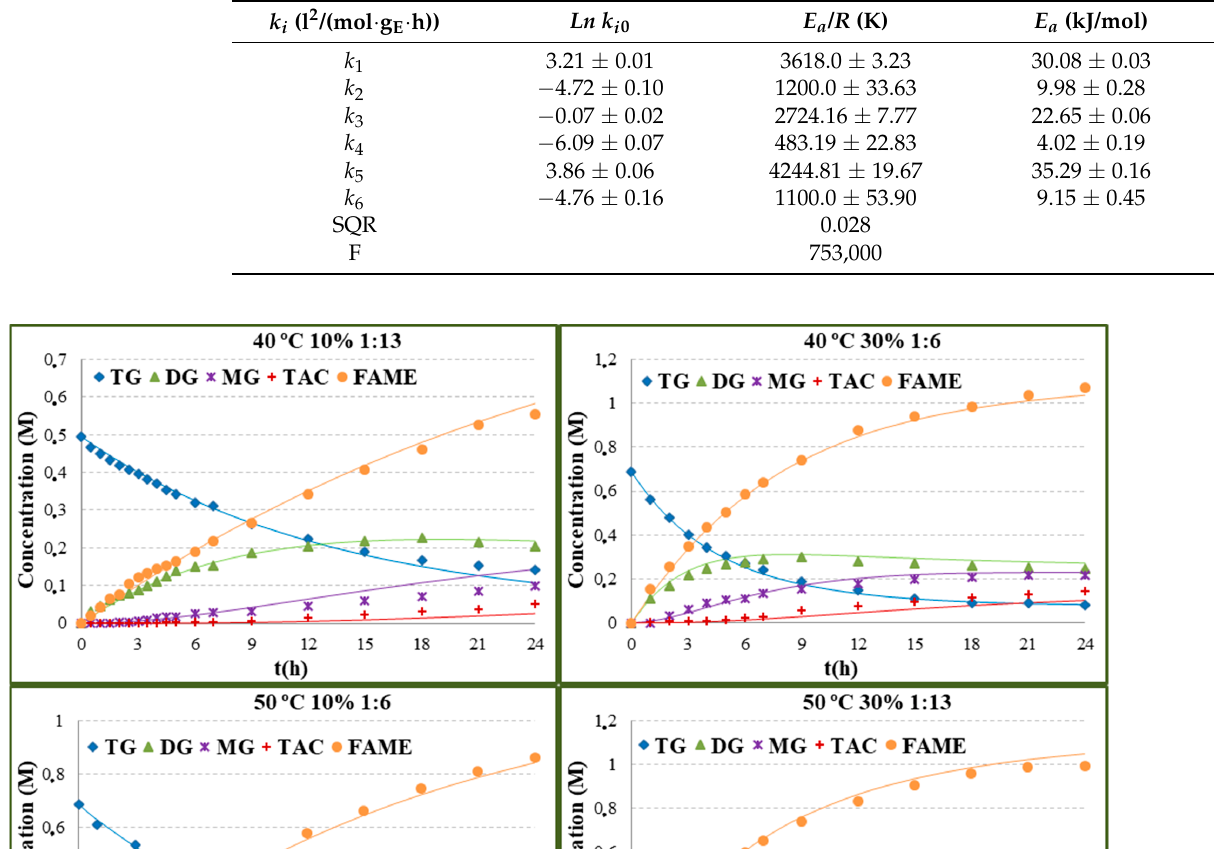
Table 3. Kinetic constants and goodness-of-fit statistical data at 95% confidence for the proposed kinetic model to fit to the interesterification of methyl acetate and castor oil triglycerides data (fitting the model to all retrieved data).